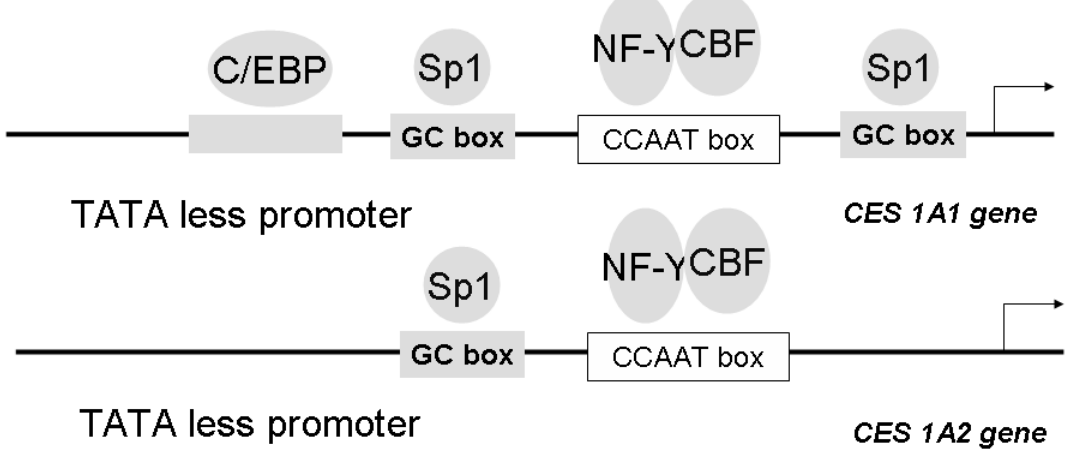
Figure 4 . Structure of the 5’ flanking region of CES 1A1 and CES 1A2 genes. Sp1 and C/EBP α could bind to each responsive element of the CES1A1 promoter but that Sp1 and C/EBP could not bind to the 5’ flanking region of the CES1A2 promoter. NF-Y, nuclear factor Y, CBF, CCAAT-binding